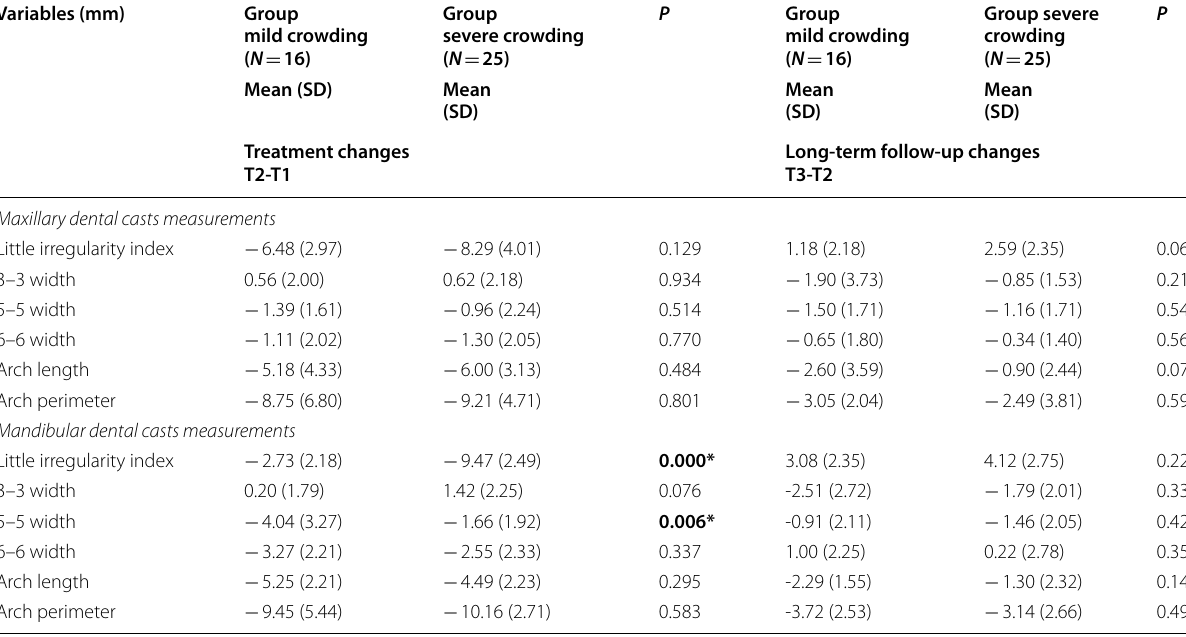
Table 3 Dental arches dimensions changes over the time in the treatment time (T2‑T1) and long‑term follow‑up time (T3‑T2) (independent t tests)